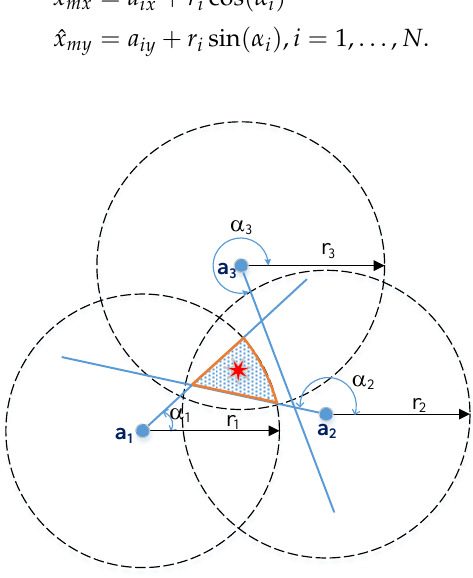
Figure 2. Hybrid nAOA/nRSSI localization. AOA—angle-of-arrival; RSSI—received signal strength